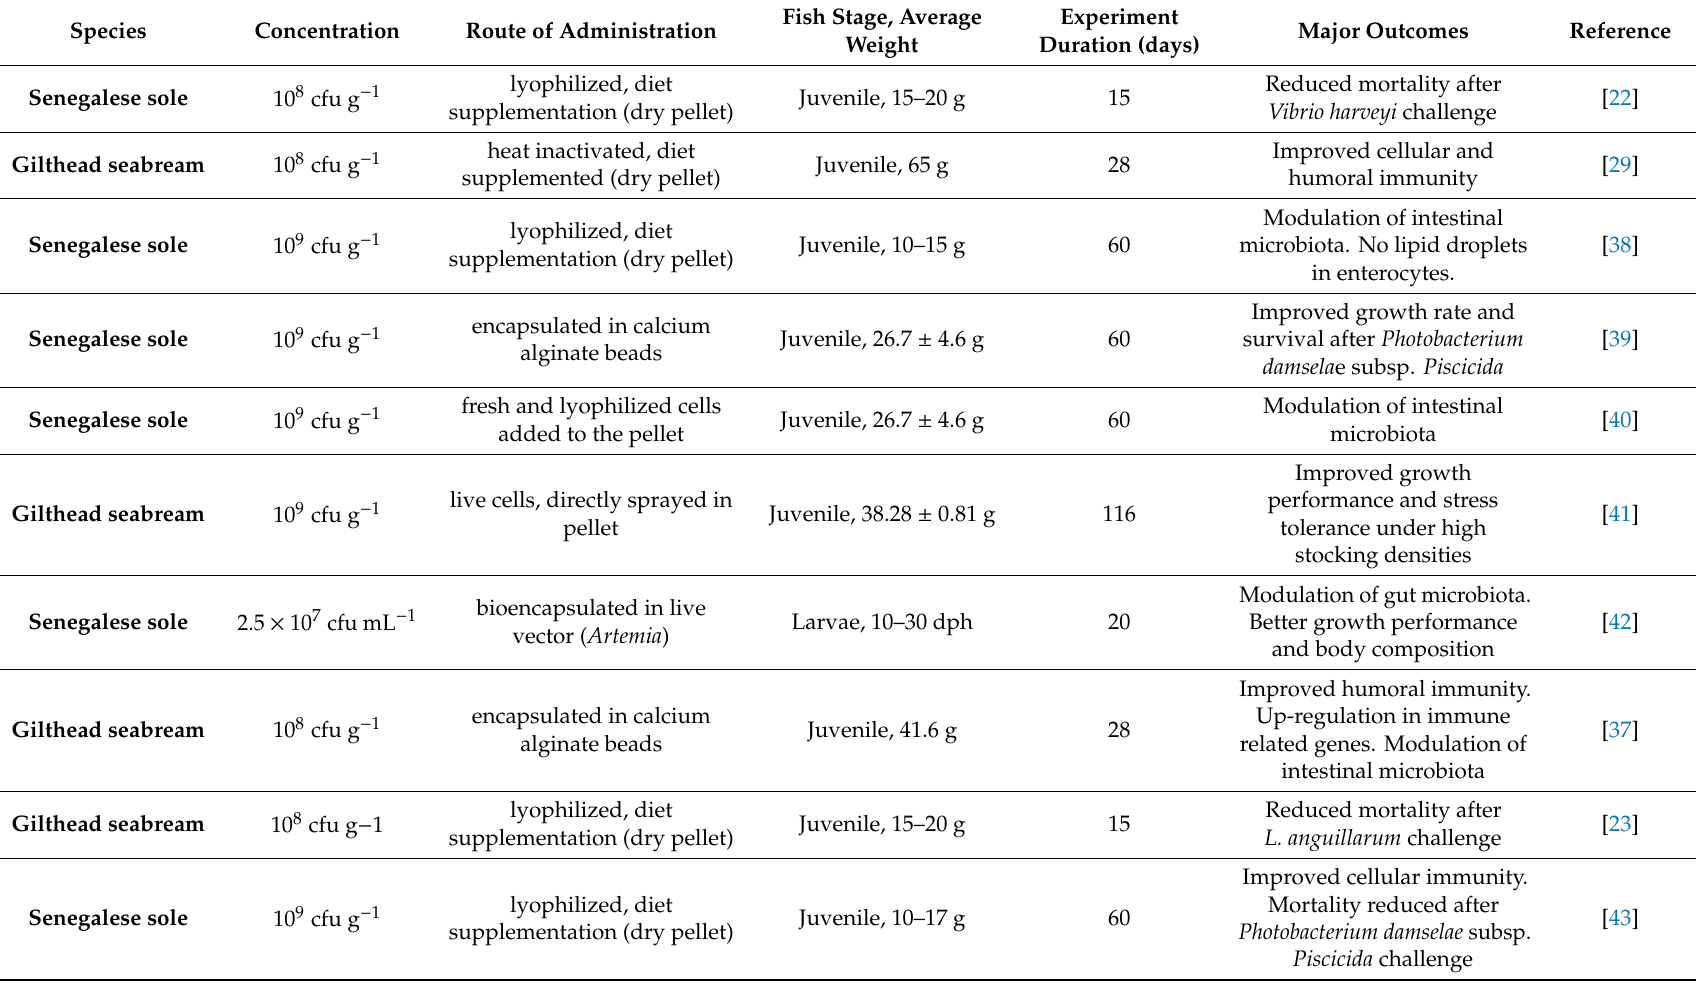
Table 1. Summary of all results and major outcomes from all studies performed using